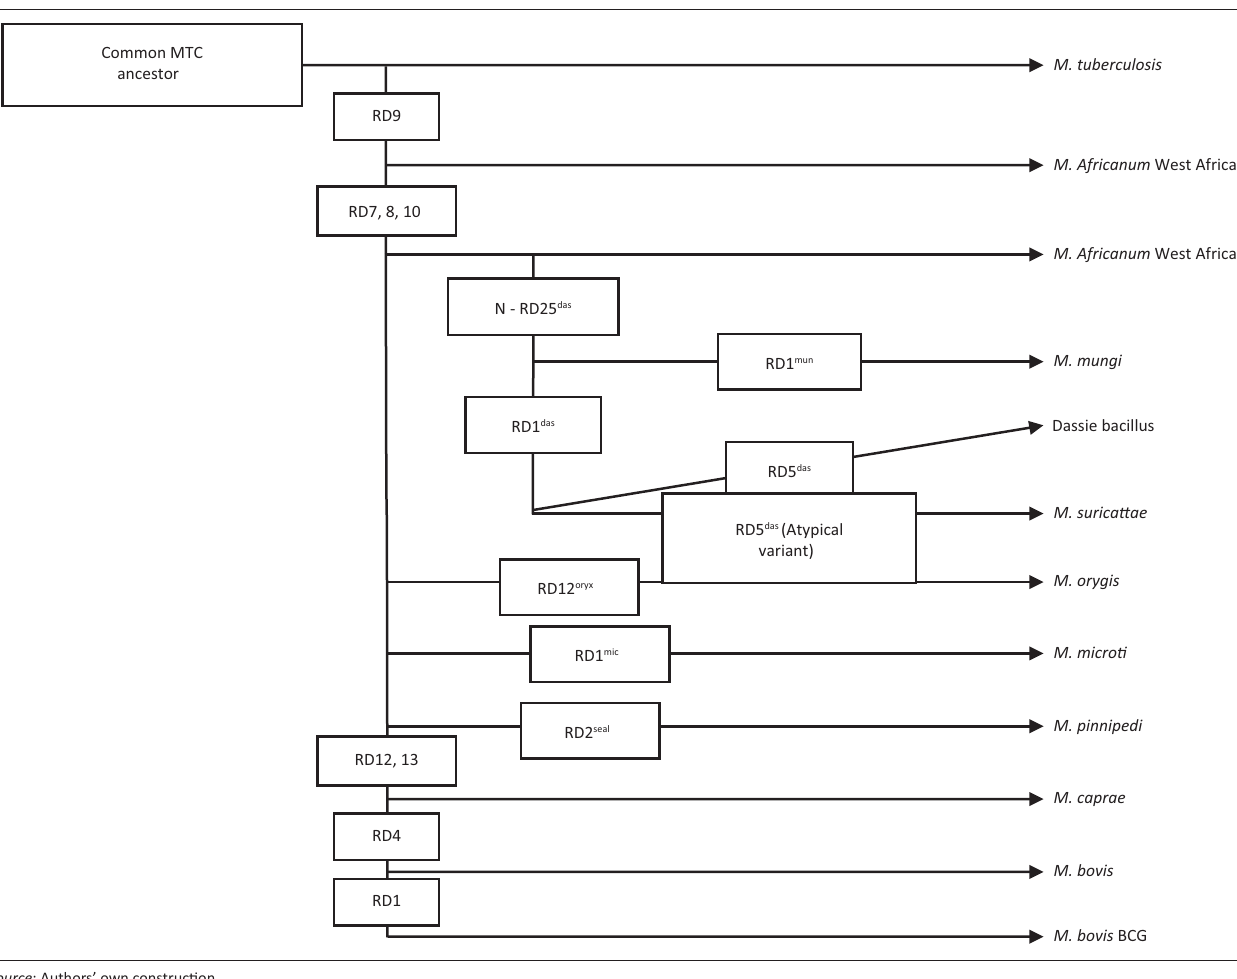
FIGURE 1: Phylogeny of the Mycobacterium tuberculosis complex indicating genetic regions of difference which differentiate between selected